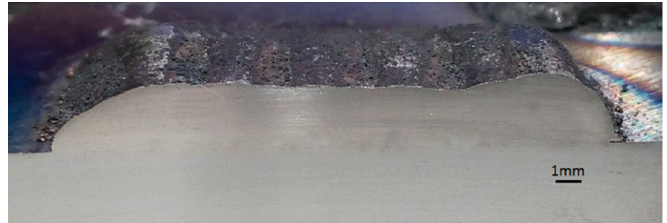
Figure 7. Macrograph of a cross section following the Zig Zag strategy.